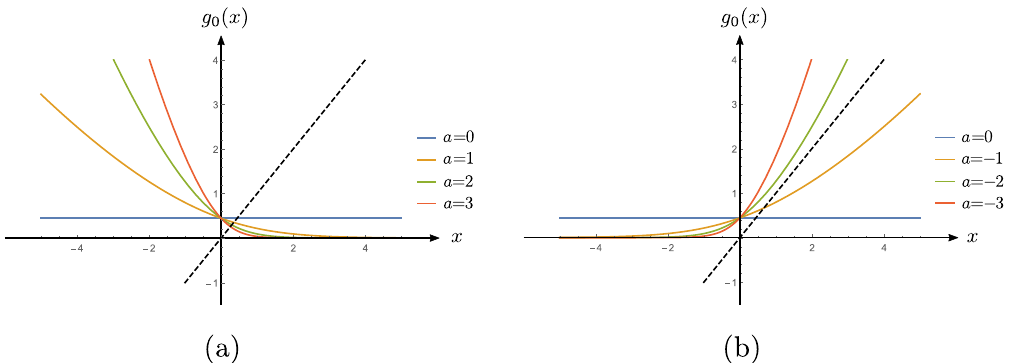
( x ) for β = 1, µ = 1 and different values of a . In the left panel, Figure 7: Plot of g 0 we take a ≥ 0 and in the right panel we take a ≤ 0. The dashed line is the plot for ( x ) always has a real the function f ( x ) = x . We see when a ≥ 0, the solution x = g 0 solution. For a ≤ 0, there is a critical value a such that for a < a , there is no real c c ( x ) . solution for the equation x = g 0